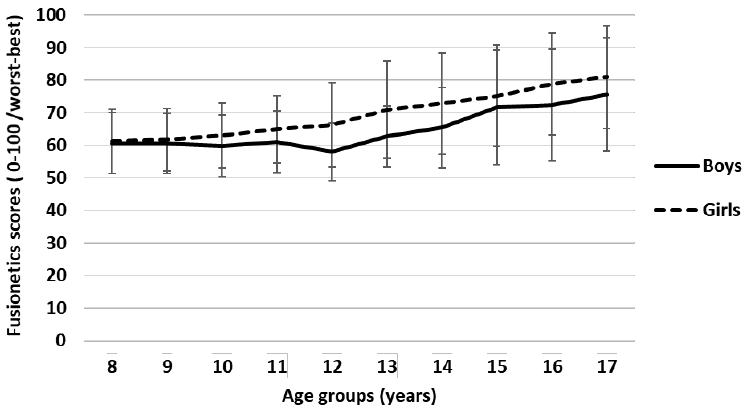
Figure 2. Age groups and Fusionetics